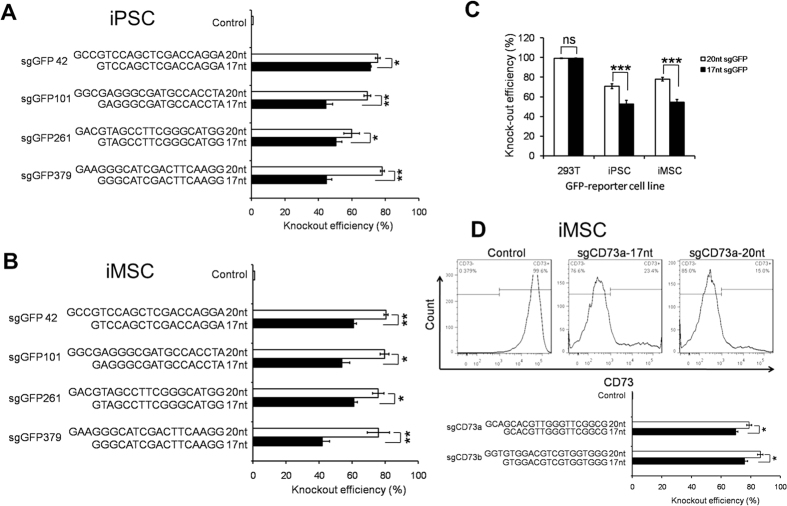
Decreased targeting activities of truncated sgRNAs compared to full-length sgRNAs in iPSCs and iMSCs.Efficiencies of GFP knockout in iPSCs (A) and iMSCs (B) after transduction of Cas9 and sgRNAs bearing full-length (20nt) or shortened sgRNAs (17nt) that target GFP sites 42, 101, 261 and 379. Lengths and sequences of the sgGFPs are shown. Data shown are mean ± SEM (n = 3). *P < 0.05; **P < 0.01; ***P < 0.001. (C) A summary of GFP knockout efficiencies by Cas9 and 17nt vs. 20nt sgGFPs that target 4 sites of the GFP reporter gene (sites 42, 101, 261 and 379) in 293T cells, iPSCs and iMSCs. Data shown are mean ± SEM (n = 4 pairs of sgGFPs). ns, not significant; ***P < 0.001. (D) Efficiencies of CD73 knockout in iMSCs after transduction of Cas9 and sgRNAs bearing full-length (20nt) or shortened sgRNAs (17nt) that target the CD73 gene sites a and b. Lengths and sequences of the sgCD73s are shown. Data shown are mean ± SEM (n = 3). *P < 0.05.